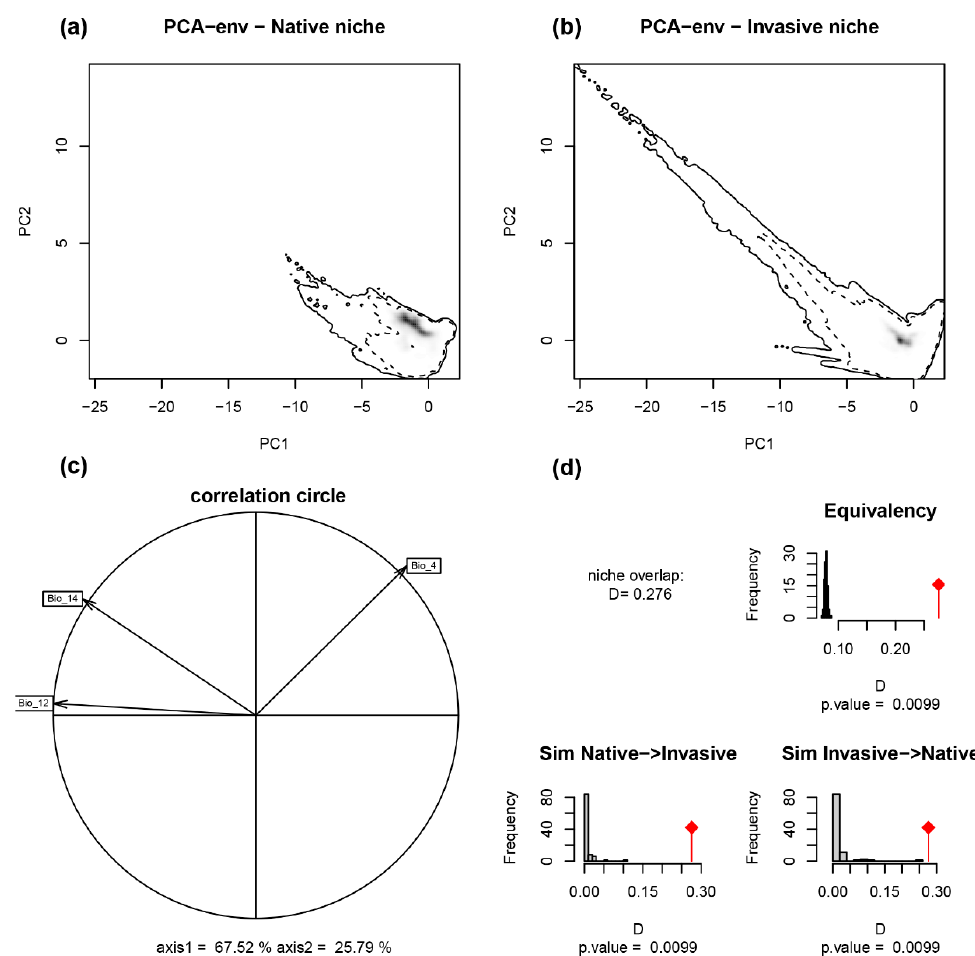
Figure 1. The native and all the invasive niches of Ambrosia artemisiifolia under the native climate conditions. Comparison of the ambient environmental conditions in native and invasive regions using a PCA calibrated by the environmental background (PCA-env) of the smoothed density of occurrences (gray shading) of ( a ) native and ( b ) all invasive sites. ( c ) The contribution of each variable to the principal component axes. ( d ) Representative histograms depicting the niche equivalence test and niche similarity test of the two regions.